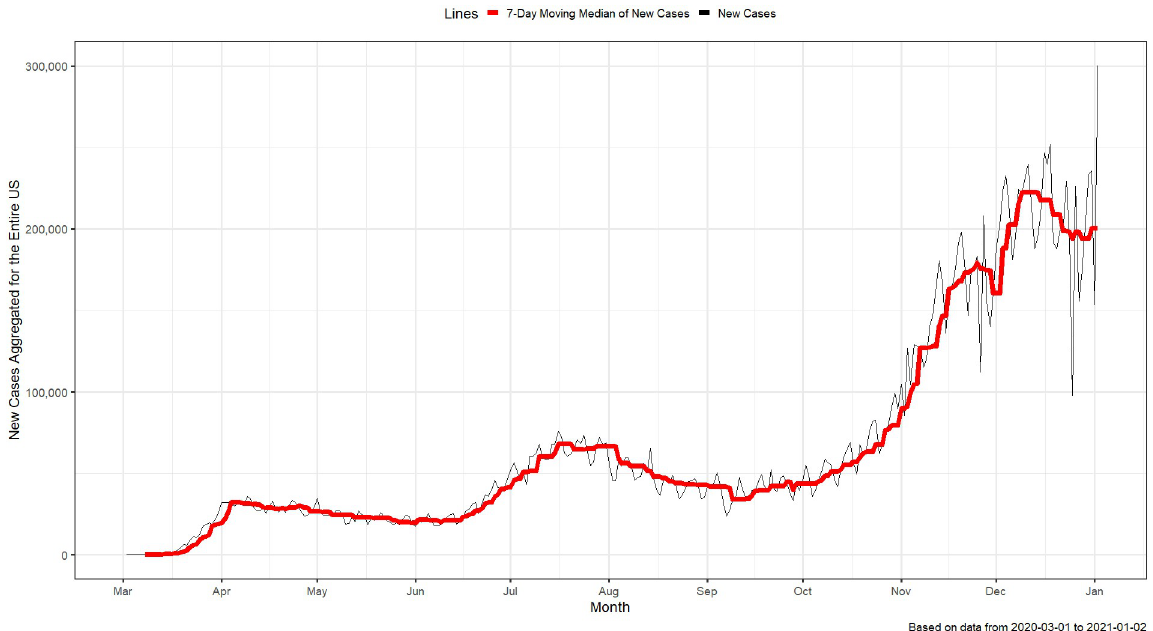
Fig 1. New COVID-19 cases for the entire US. The black and red lines correspond to the reported daily new cases, and the 7-day moving median of daily new cases, respectively.